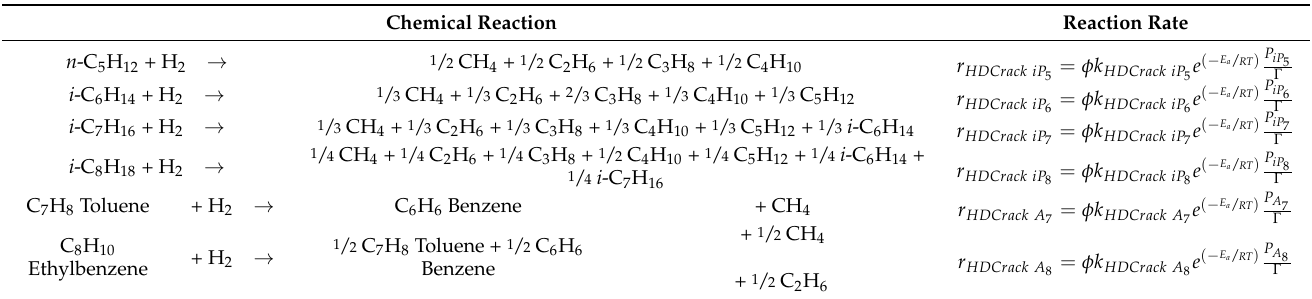
Table 8. Hydrocracking reactions. Chemical